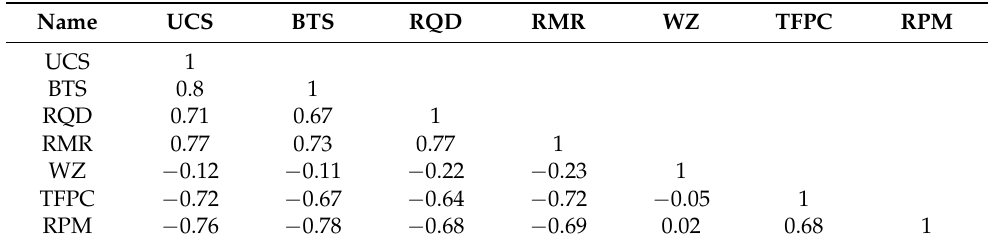
Table 2. Correlation matrix for input